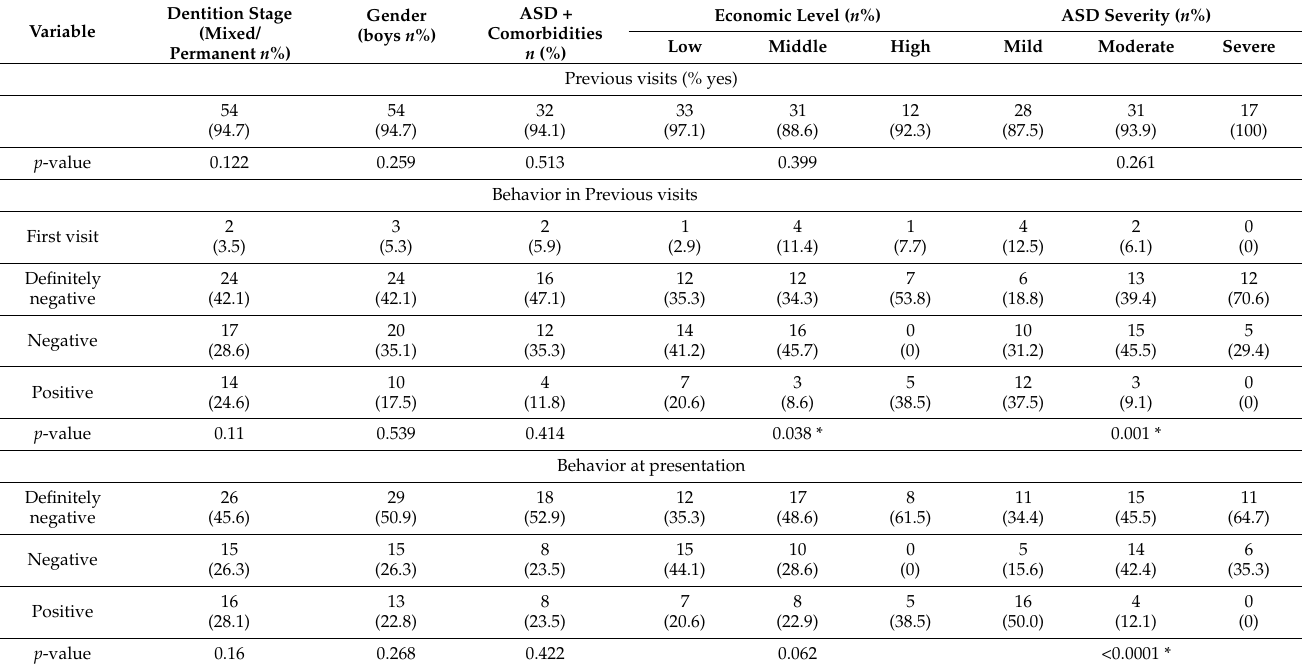
Table 2. Association of the demographic profile of ASD children ( n = 82) and their medical status with their previous dental visits and